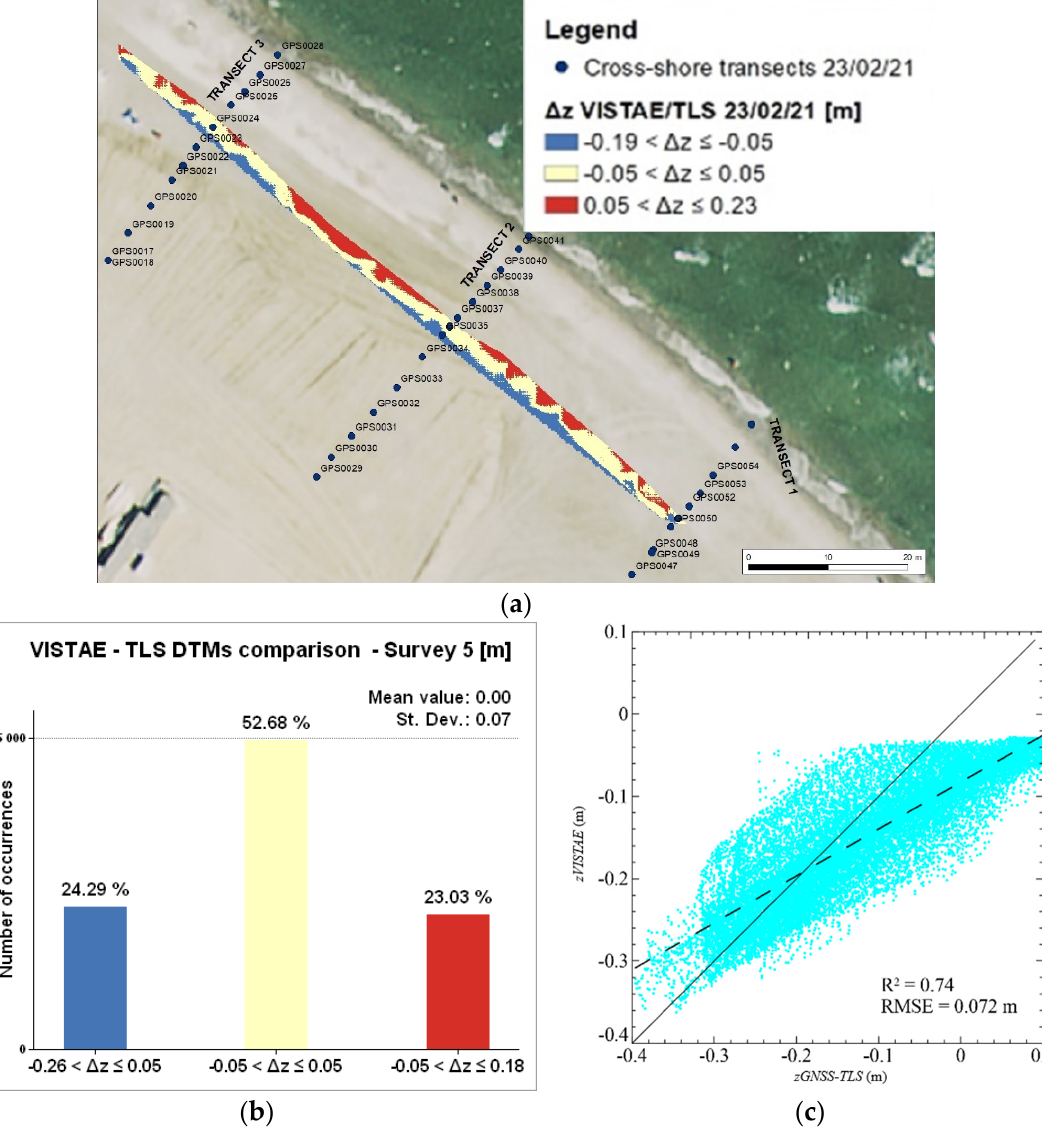
Figure 10. ( a ) Height difference between the low-cost camera VISTAE and TLS elevation models obtained from survey 5 (23 February 2021); mean value and standard deviation (0.00 ± 0.07) m. ( b ) Histogram representing classes of Δ z distribution as percentages. ( c ) Scatter plot with linear regres- sion parameters between VISTAE and GNSS elevations (in m); solid line is the bisector (slope 1:1), while dashed line is a linear fitting of the data; R 2 and RMSE are 0.90 and 0.089 m.